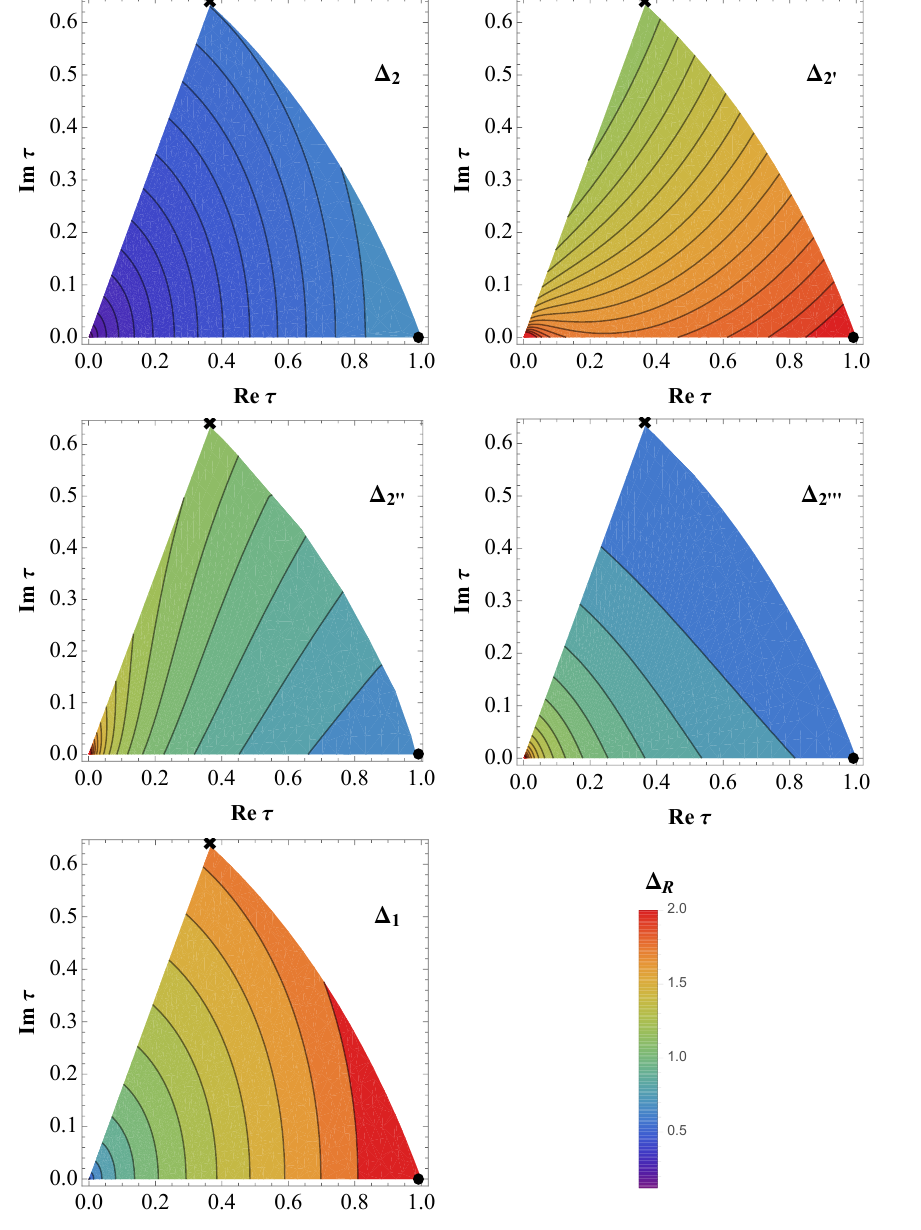
Figure 13 . Exact scalar singlet and doublets scaling dimensions (D.6) in the fundamental domain F in (cid:12)gure 1 for d = 2. The cross and circle denote the Z